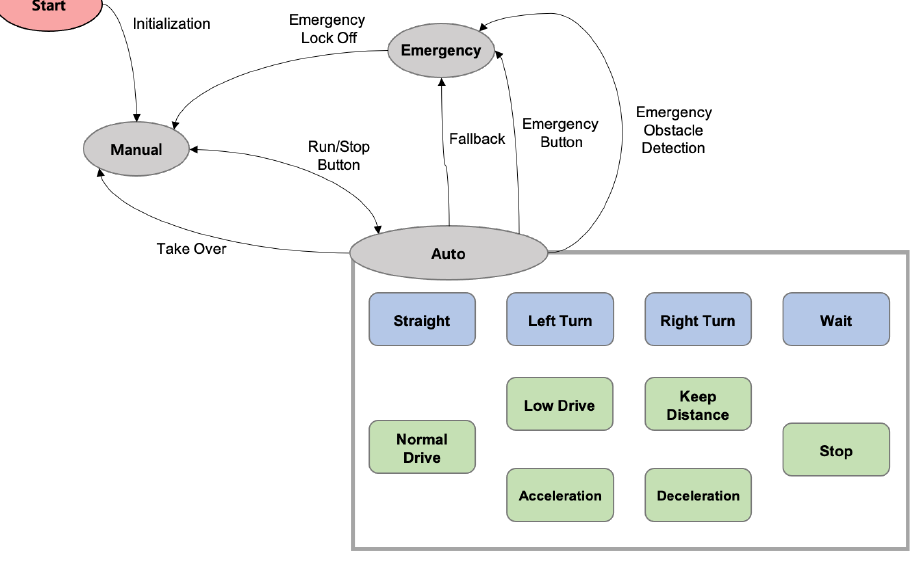
Figure 14. Motion state